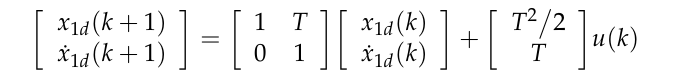
Figure 3. The structure of the nonlinear filter-based trajectory planner. The integrator chains are mathematically represented